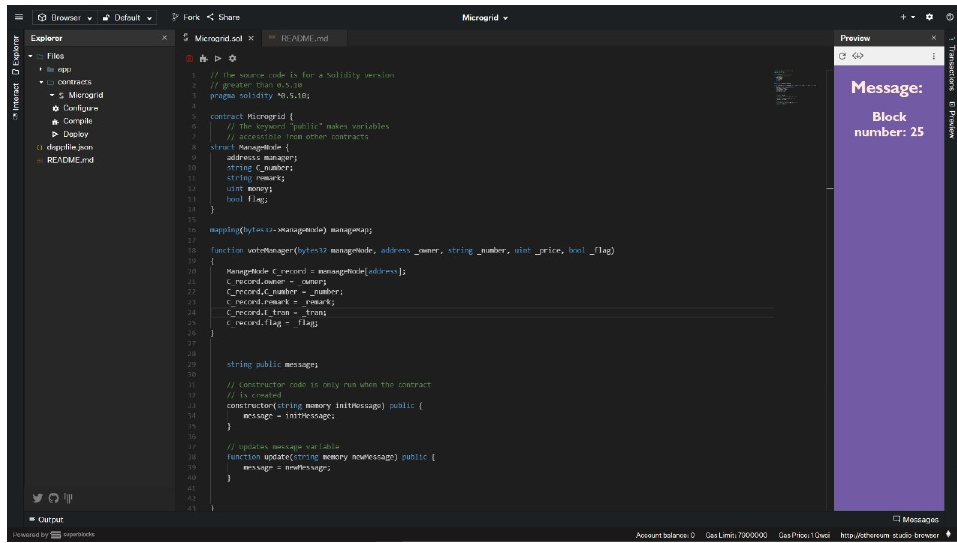
Figure 9. Experimental interface based on Ethereum technology.